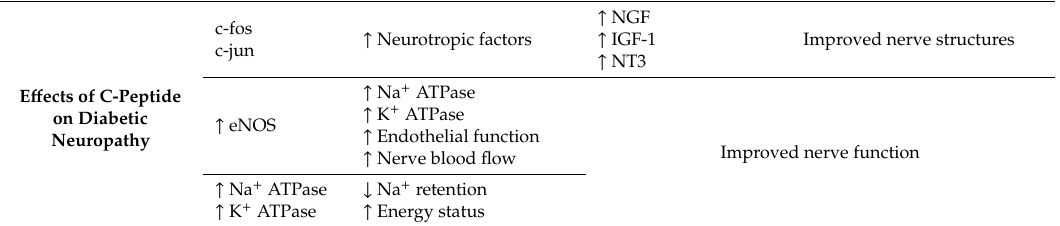
E ff ects of C-Peptide on